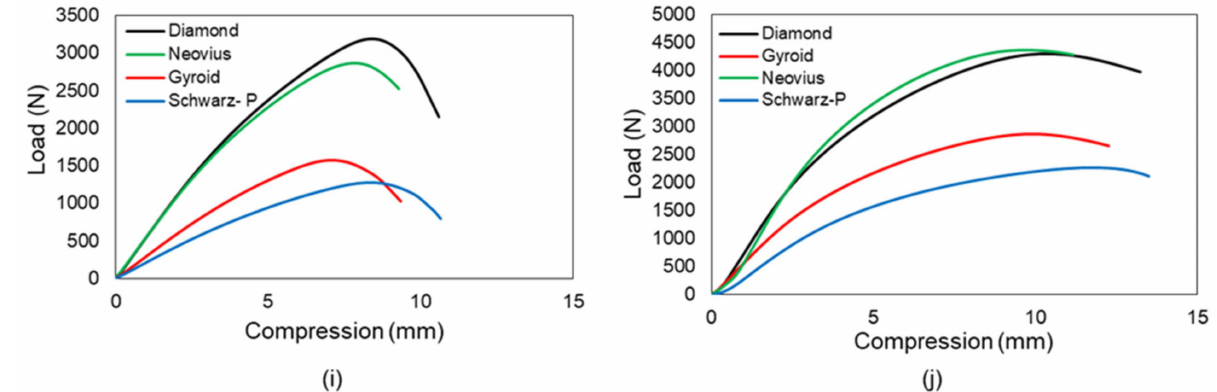
Figure 10. Graphs of load compression. The graphs a, b, c, d, e, f, g and h reveal that the compression test results for the three specimens of each sample are identical, indicating that printing performance is excellent. For subsequent calculations, average values are used. Samples at 2 × 2 × 8: ( a ) Schwarz- P, ( b ) Gyroid, ( c ) Diamond and ( d ) Neovius. Samples at 2 × 2 × 16: ( e ) Schwarz-P, ( f ) Gyroid, ( g ) Diamond and ( h ) Neovius. ( i ) Comparison of four 2 × 2 × 16 samples reveals a significant variance in their critical buckling loads average values. ( j ) Comparing the average results of four 2 × 2 × 8 samples reveals that Diamond and Neovius exhibit roughly the same load, but Diamond’s critical buckling load is the greatest, whilst Schwarz-P structures shows least